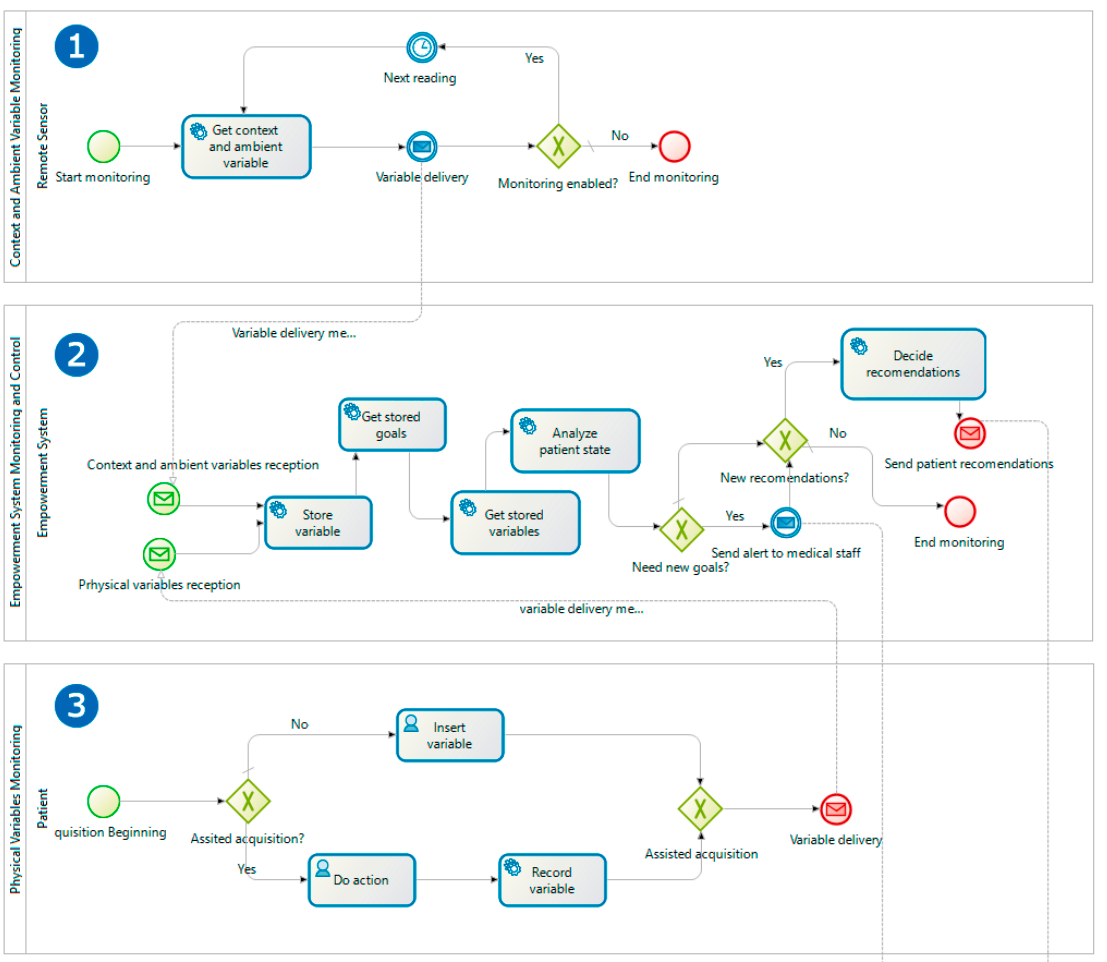
Figure 4. Process redesign (TO_BE). Patient empowerment cycle from variables monitoring cycle.